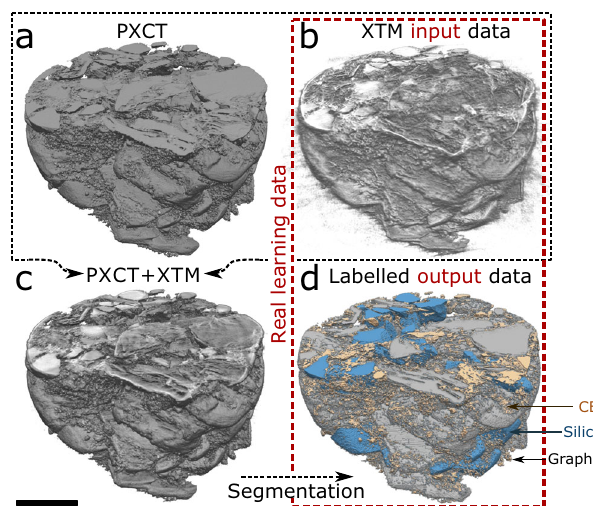
Fig. 3 Real learning data. ( a ) Ptychographic x-ray computed tomography (PXCT) and ( b ) x-ray tomographic microscopy (XTM) is performed on the graphite-silicon composite electrodes. Data from these two imaging approaches are ( c ) combined and ( d ) segmented. As indicated by the red box, real training data are made up of input images (the XTM images in ( b )) and output images (the segmented, multimodal images in ( d )). Scale bar is 10 µ pore space and their contour can only be guessed based on the bright edge-enhancement effect. Graph-based processing (using a 3D implementation of the random walker algorithm 48 ) (Fig. 2c) is better able to identify particle boundaries but fails in low